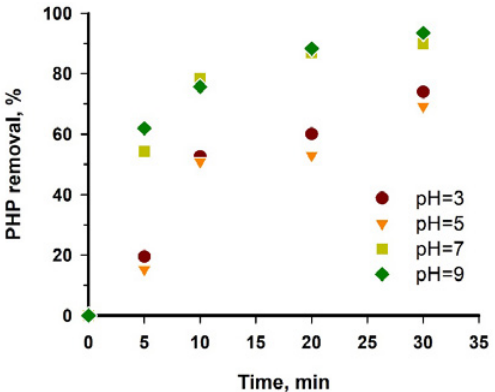
Fig. 6. PHP removal efficiency of the HSEF at different applied currents. Reaction conditions: pH=7, 0.1Fe-ZSM-5 concentration of 0.2 gL -1 , ultrasonic power of 600 WL -1